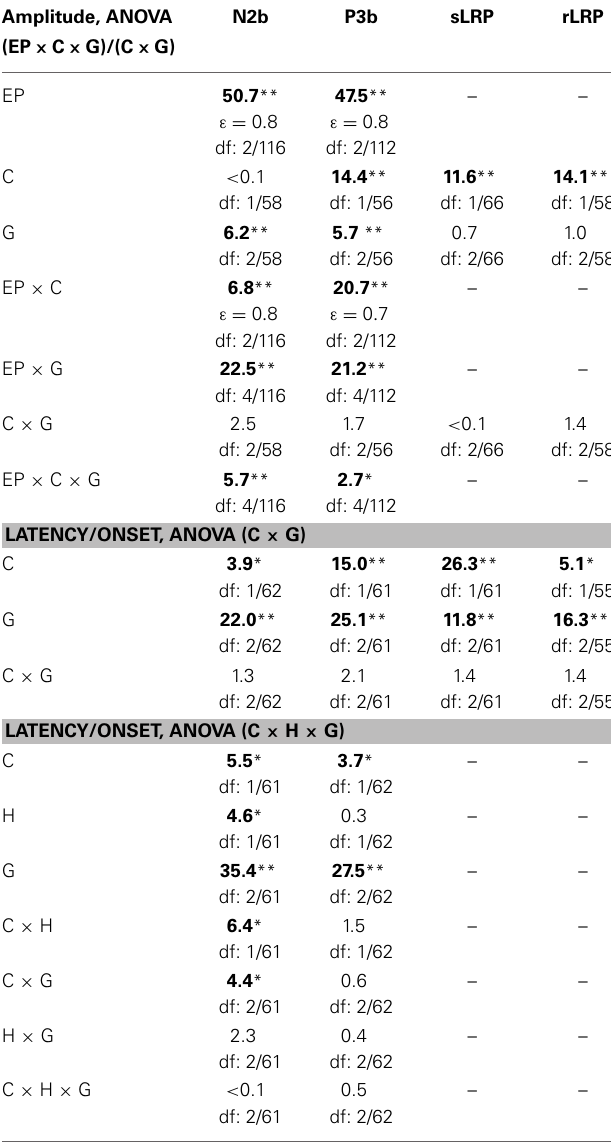
Table 2 | F -values from: three-factor ANOVAs (Electrode Position × Condition × Group) for N2b and P3b amplitudes at midline, two-factor ANOVAs (Condition × Group) for N2b and P3b latencies at midline and values for sLRP and rLPR amplitudes and onsets, and three-factor ANOVAs (Condition × Hemisphere × Group) for N2b and P3b latencies at lateral locations.